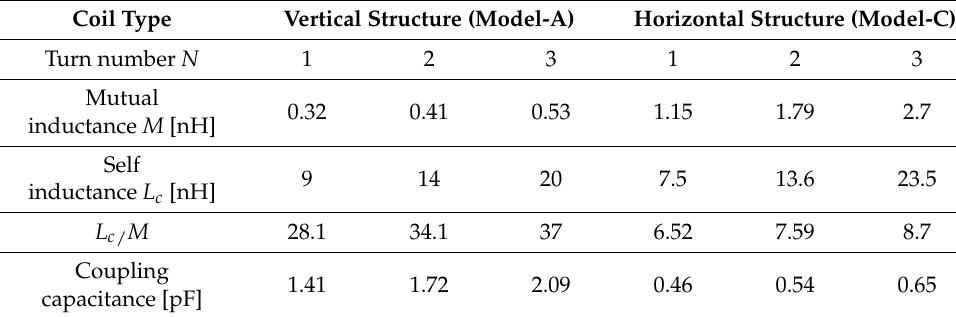
Table 5. Influence under different turn-numbers with the FEM. Coil Type